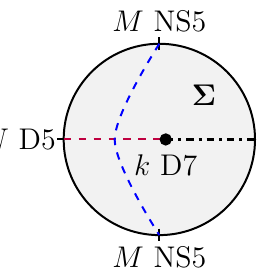
Figure 12. Disc representation of the D5/NS5 2 /D7 supergravity solution, with the black dot- dashed line showing the branch cut. The fundamental string connecting the D5-brane pole to the D7 brane puncture is shown as purple dashed line, the D1-brane connecting the NS5-brane poles is shown as blue dashed